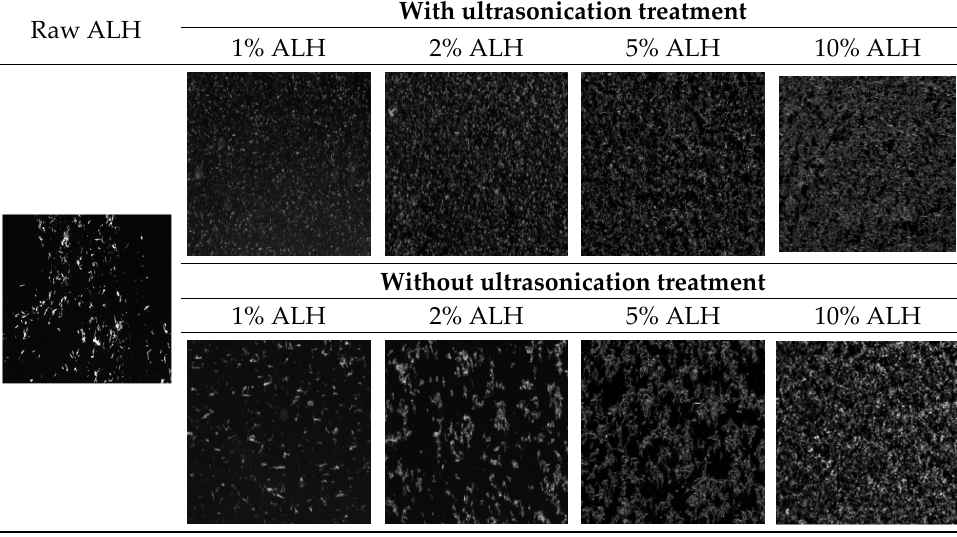
Figure 6. Optical microscope observation of ALH particles from raw ALH, ALH-loaded Su-SNEDDS (F6) with or without ultrasonication treatment.